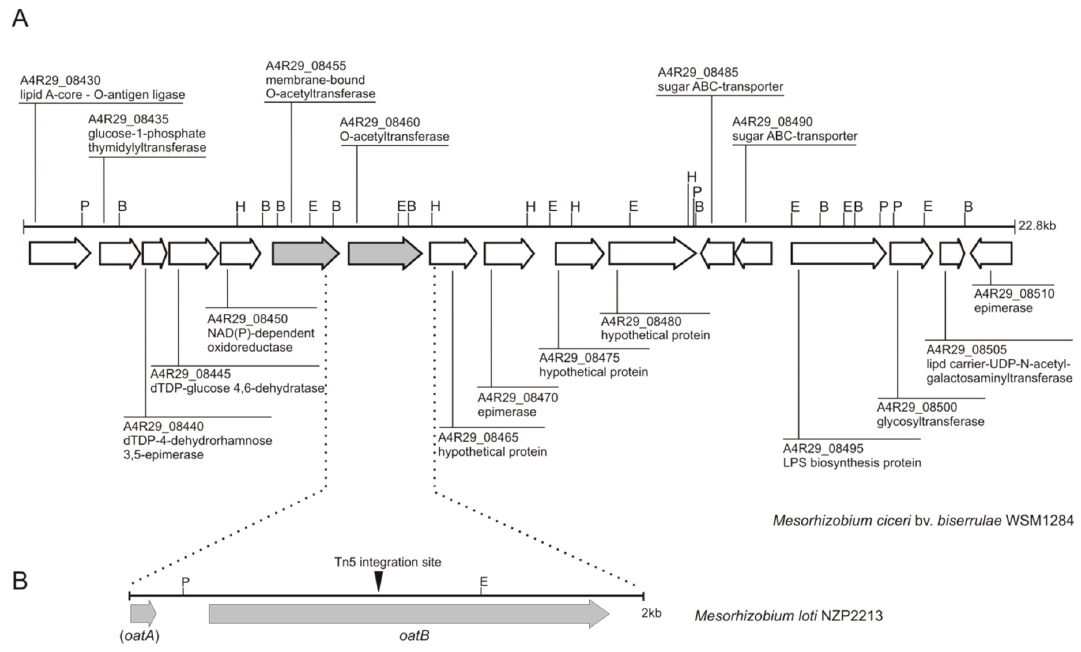
Figure 1. Physical and genetic map of: ( A ) a chromosomal region of M. ciceri bv. biserrulae WSM1284 grouping genes implicated in lipopolysaccharide biosynthesis and polymerization. The sequences flanking the A4R29_08460 gene were used to design primers for amplification of the corresponding fragment from the chromosome of M. loti NZP2213. Hypothetical functions of gene products come from a GenBank annotation, except for the A4R29_08455 and A4R29_08460 genes, the function of which was predicted in this work on the basis of similarity of their amino acid sequences to proteins found in genome databases; ( B ) a chromosomal region of M. loti NZP2213 covering the 3 ′ -end of the oatA gene and the whole oatB gene, which was cloned into the broad-host range vector and used to complement the NZP2213.1 transposon mutant described previously [7]. Marked is the Tn5 integration site within the oatB gene. P: PstI, B: BamHI, H: HindIII, and E: EcoRI.